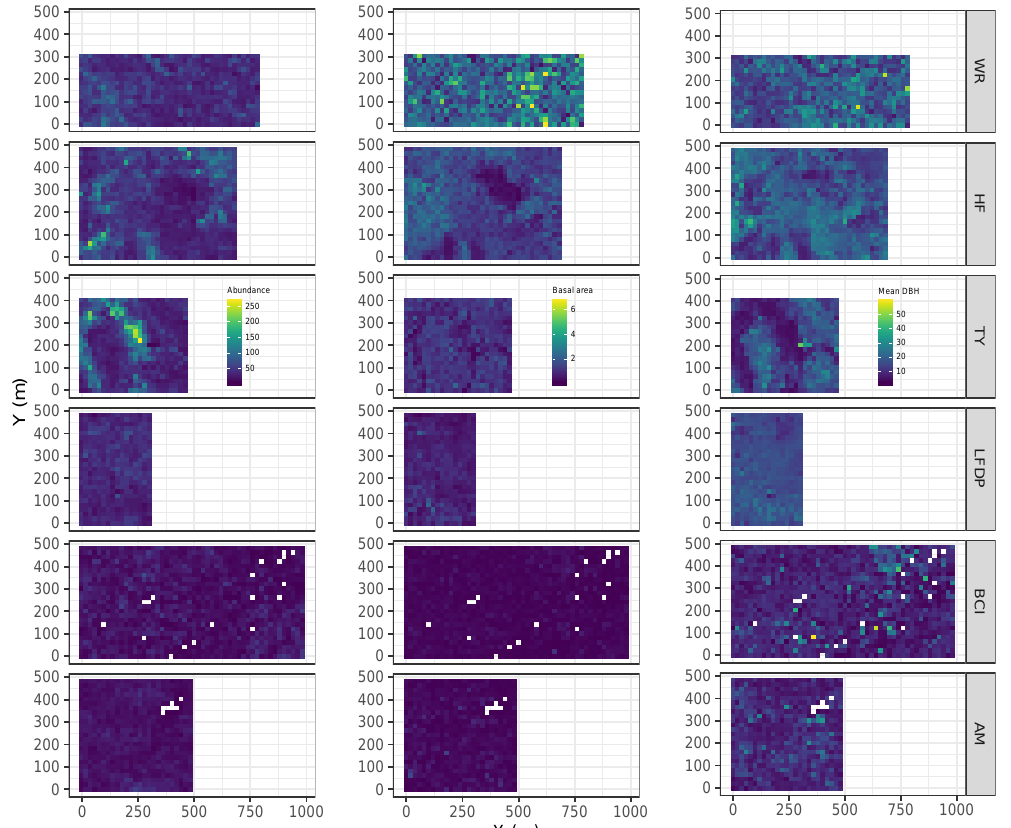
Figure 6. Abundance, total basal area, and mean basal area of all hypothesized foundation species and other focal species (Table 1) in the six 20-m rasterized forest dynamics plots. Sites are ordered top-to-bottom by decreasing latitude, and each plot is scaled relative to the 50-ha BCI plot. White squares in the BCI and AM panels indicate none of the focal species were present in that subplot.